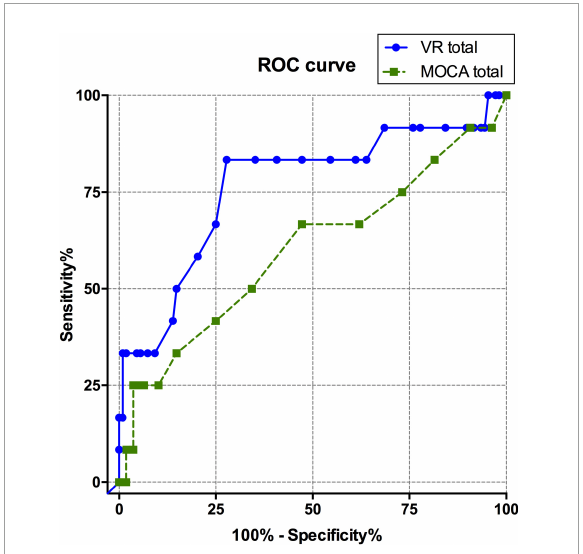
FIGURE2 ROC curve comparison between total scores of VARABOM test and MOCA-K test. ROC curves with VR total score (blue-solid line) and MOCA total score (green-dashed line). ROC curve, receiver operating characteristic curve; VARABOM, virtual reality-based MCI monitoring; MOCA-K, Montreal Cognitive Assessment-Korean